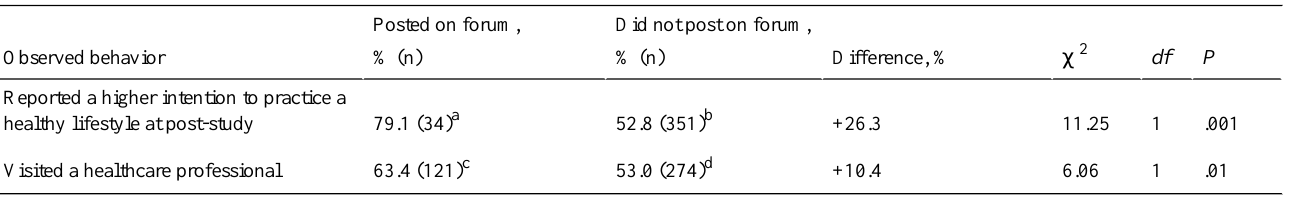
Table 2. Table 2. Users of online forum versus nonusers.